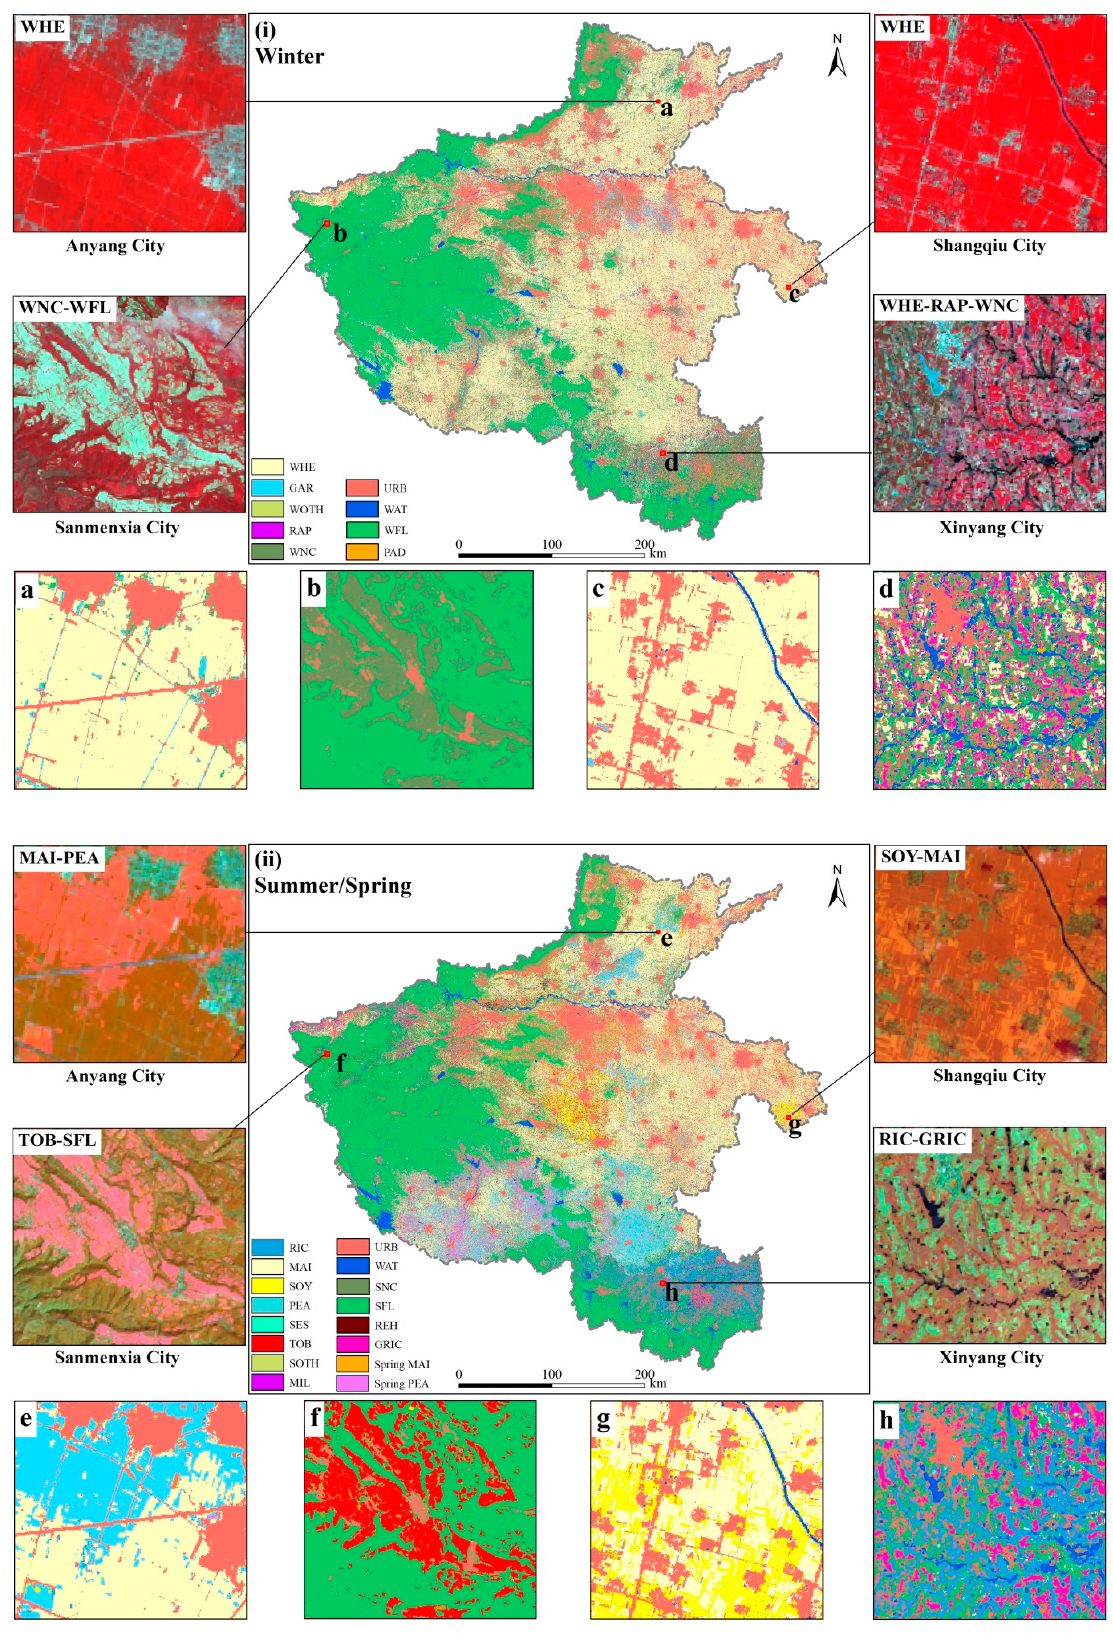
Figure 12. Mapping of reclassification results in different seasons. Multi–temporal results in different regions ( a – h ).